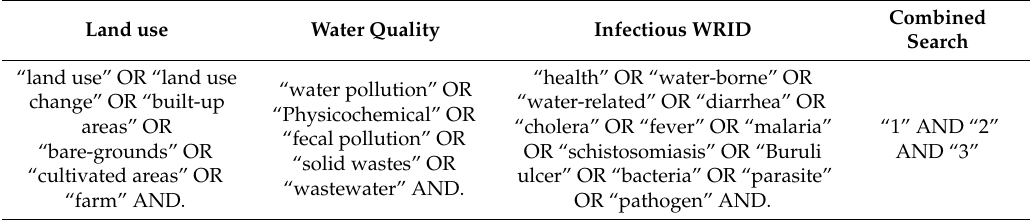
Table 1. Keywords and syntax used for the literature search.